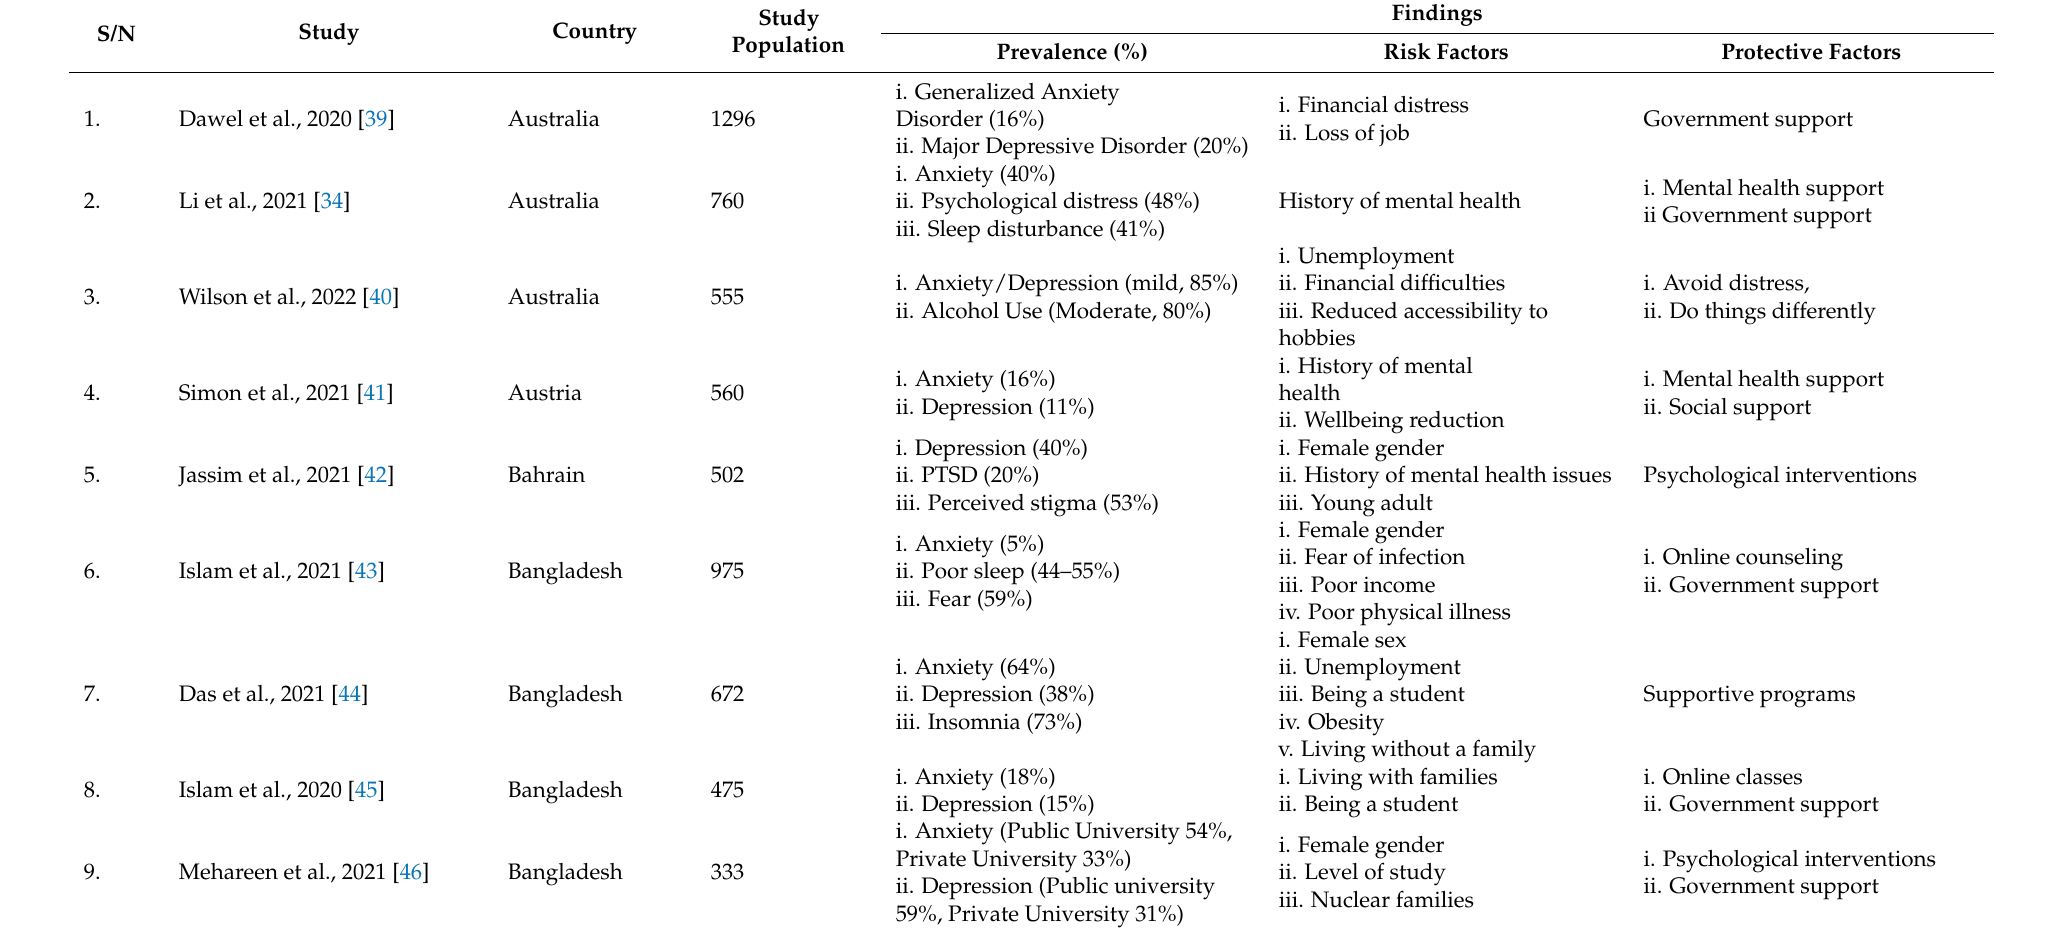
Table 1. Surveys Outcomes Showing the Prevalence, Risks, and Protective Factors to Mental Health